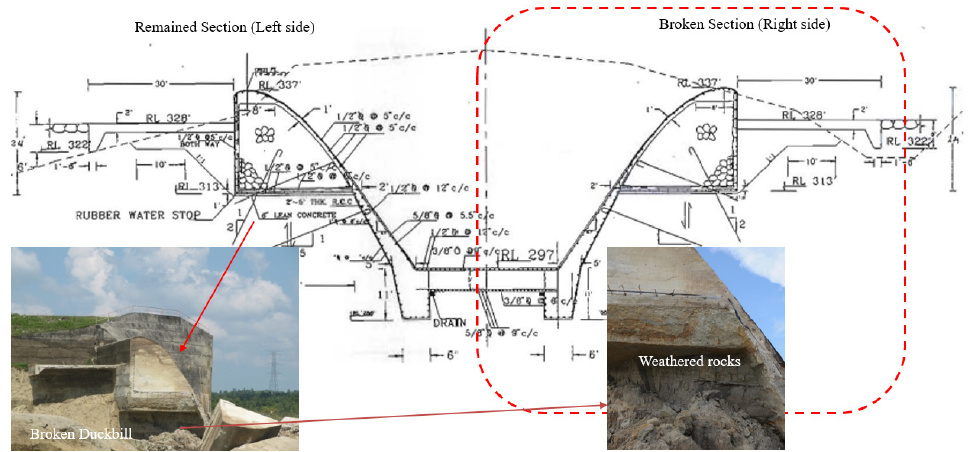
Figure 5. The typical cross-section of the collapsed spillway (design by the